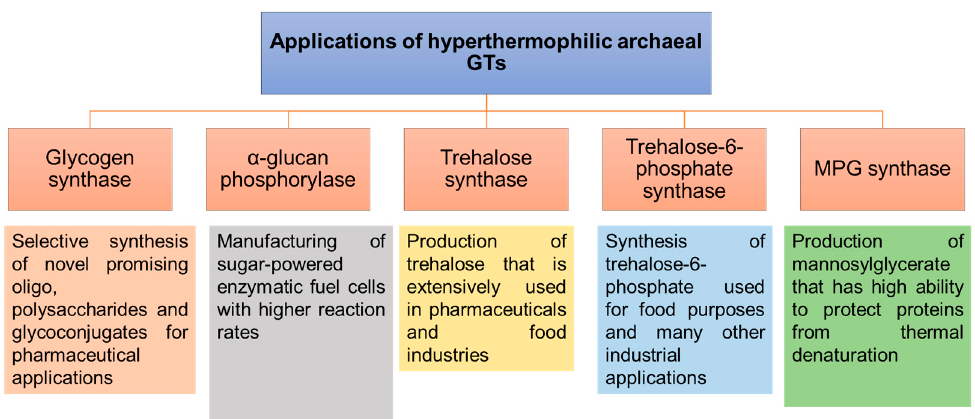
Figure 9. Applications of hyperthermophilic archaeal GTs involved in the synthesis of carbohydrates and glycoconjugates that correspond to glycogen synthases, α -glucan phosphorylases, trehalose synthases, trehalose-6-phosphate synthases and MPG synthases [146–150].